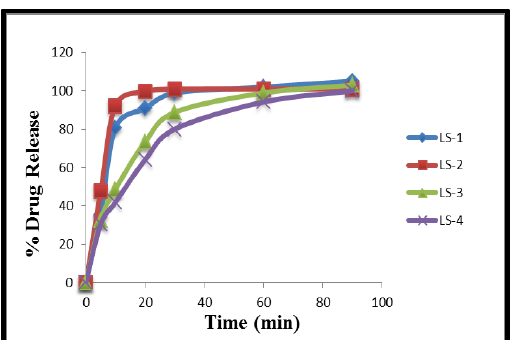
Figure 15. Dissolution profiles of clopidogrel from liquisolid compacts (LS 1 – 4) in phosphate buffer (pH 6.8) with 1% SLS at